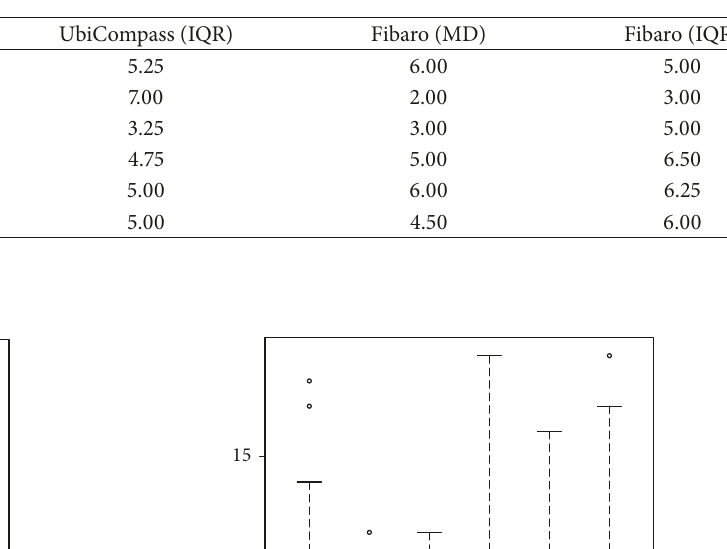
Table 1: Median values for the UbiCompass prototype and the Fibaro application.